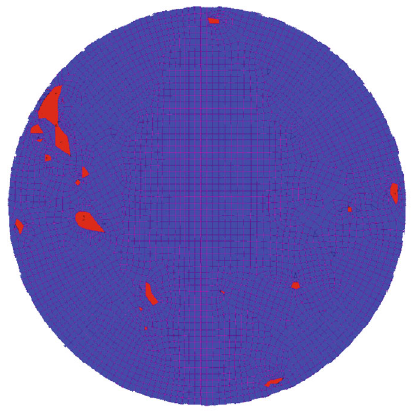
Figure 6: Microstructural grid model of sandstone with natural